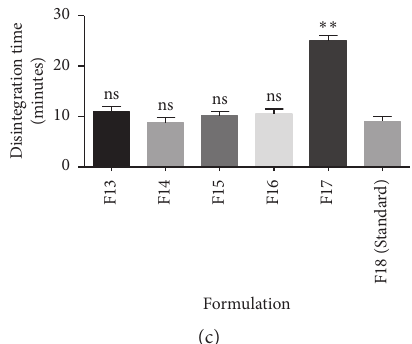
Figure 6: Comparative analysis on the disintegration time of pectin from various genotypes as disintegrants ((a) 5% w/w, (b) 7.5% w/w, and (c) 10% w/w) and a standard disintegrant using t -test. Values are mean ± SD ( n � 2). ∗ p ≤ 0 . 05, ∗∗ p ≤ 0 . 01, and p > 0 . 05 not significant (ns).